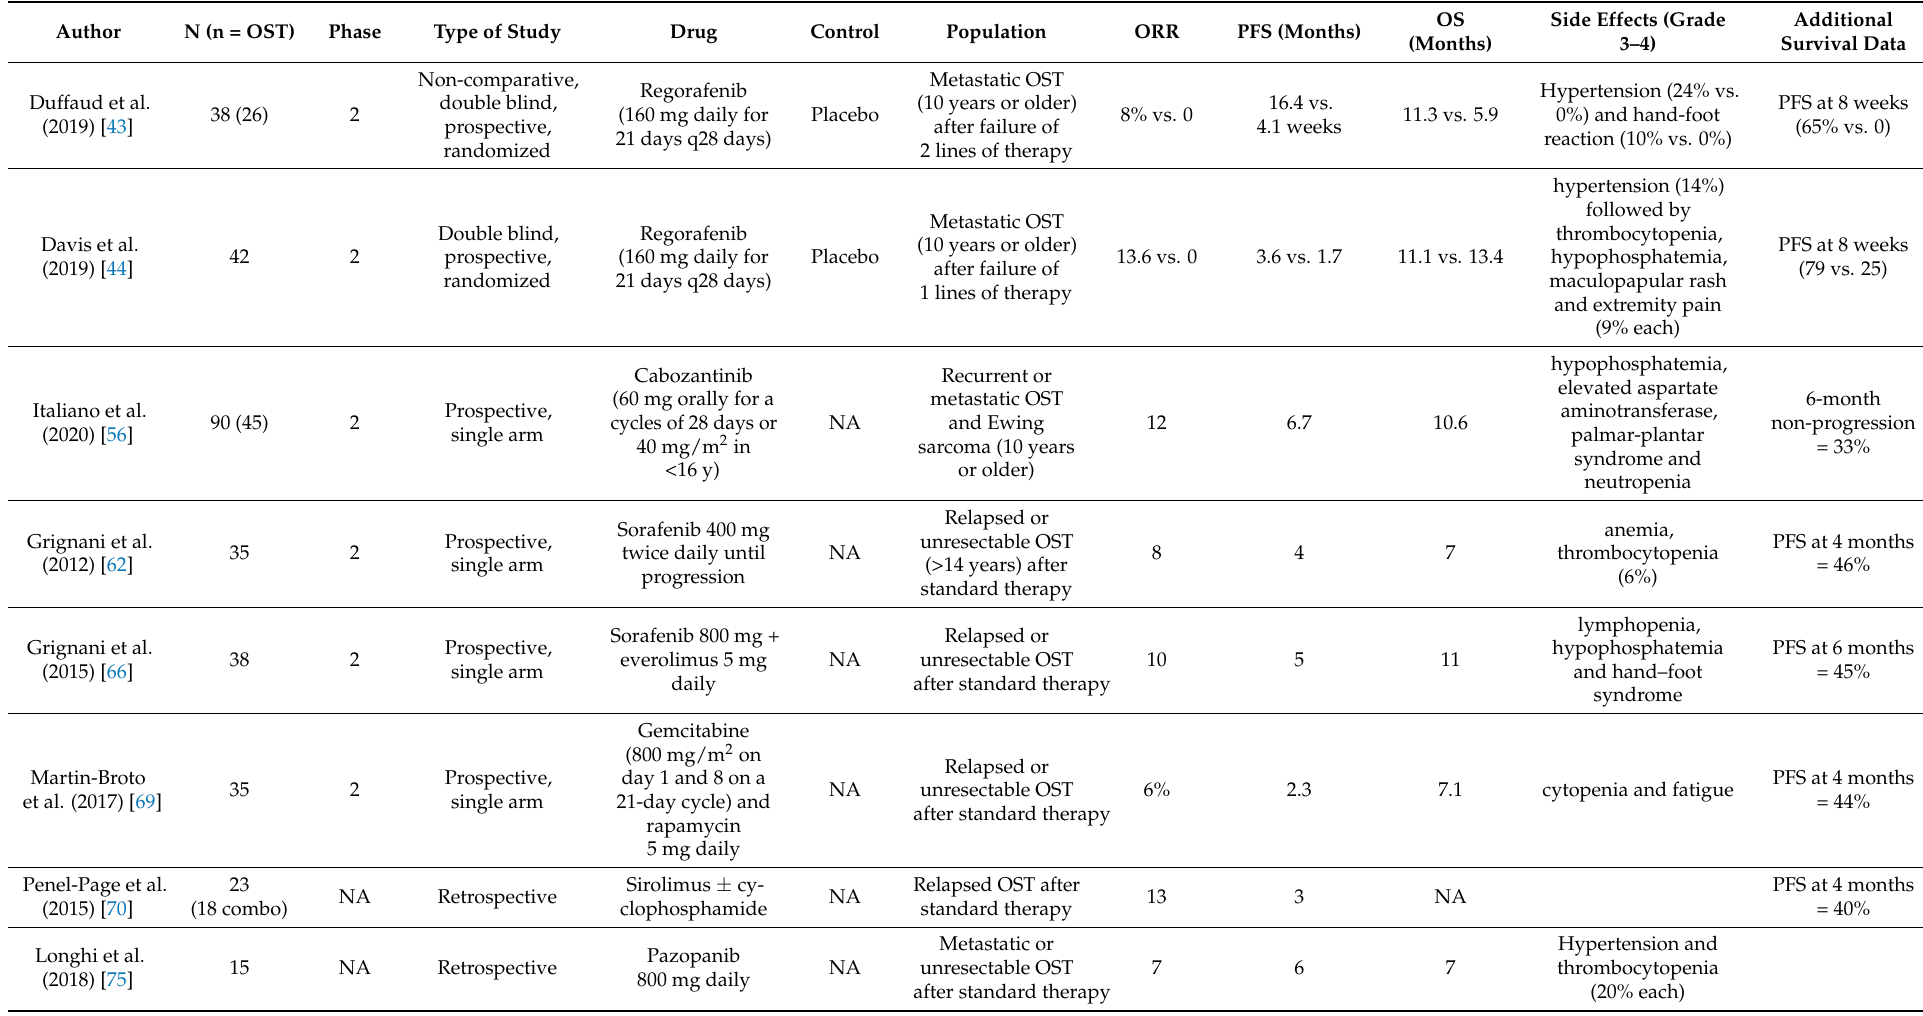
Table 1. Clinical data on the use of anti-VEGF agents in osteosarcoma